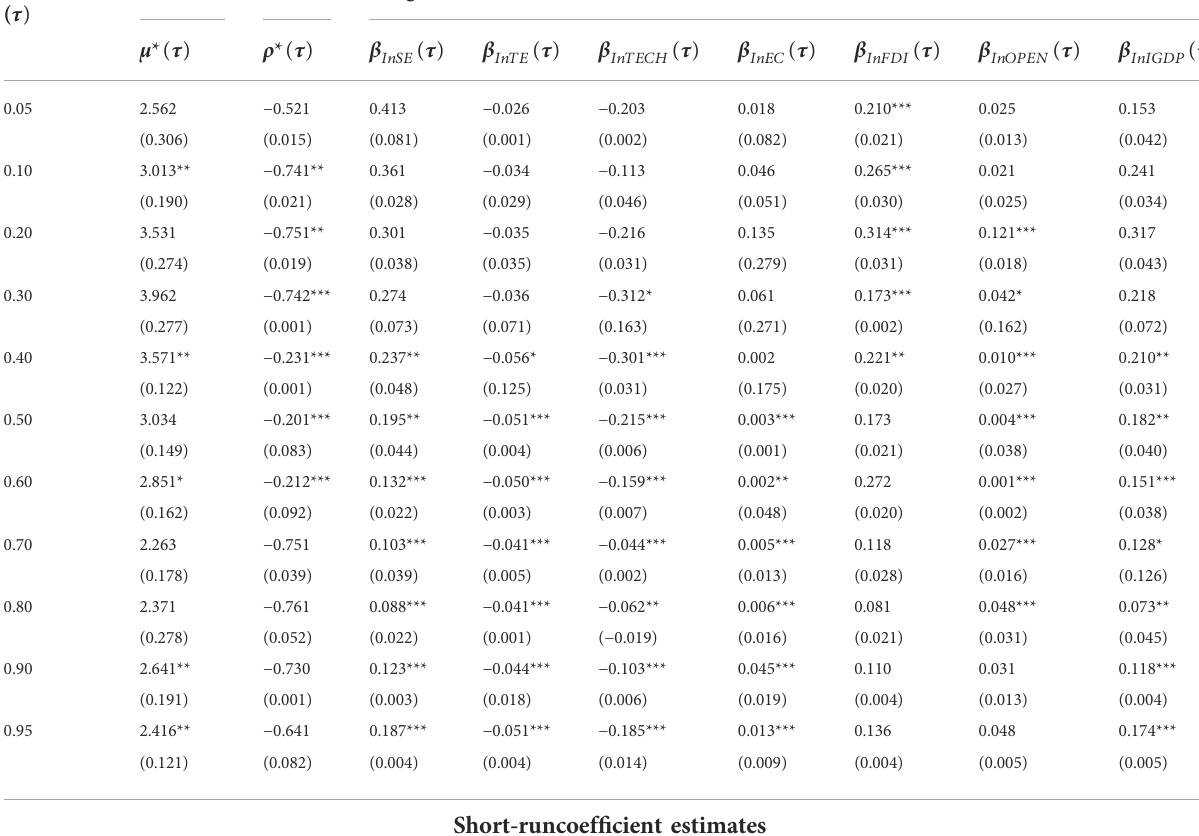
TABLE 6 Results of quantile autoregressive distributed lag model